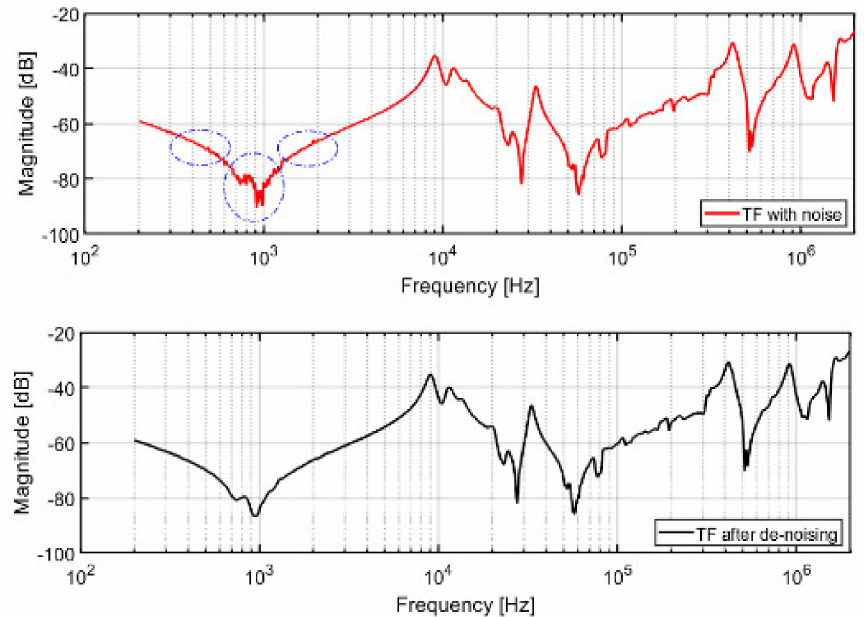
Figure 4. Comparison of the transfer functions (TFs) before ( up ) and after noise removal ( down